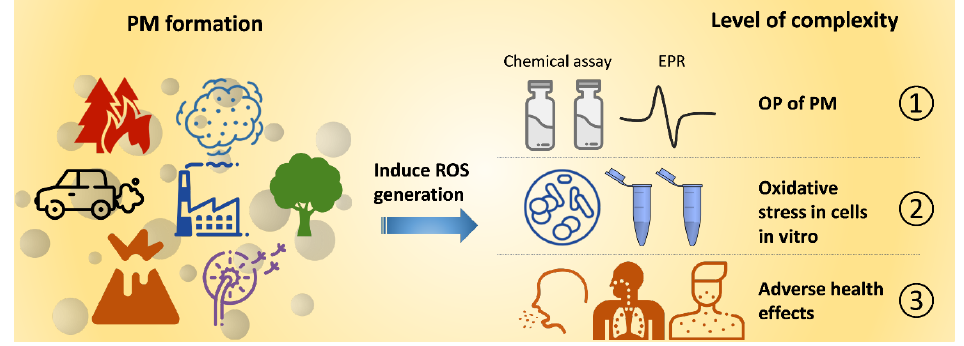
Figure 1. Sources, toxicity measurement, and adverse health effects of particulate matter (PM). Increasing levels of complexity involved in (1) the oxidative potential (OP) measurement of PM, (2) the quantification of oxidative stress in cells in vitro, and (3) PM exposure and epidemiological studies on the adverse health e ff ects of